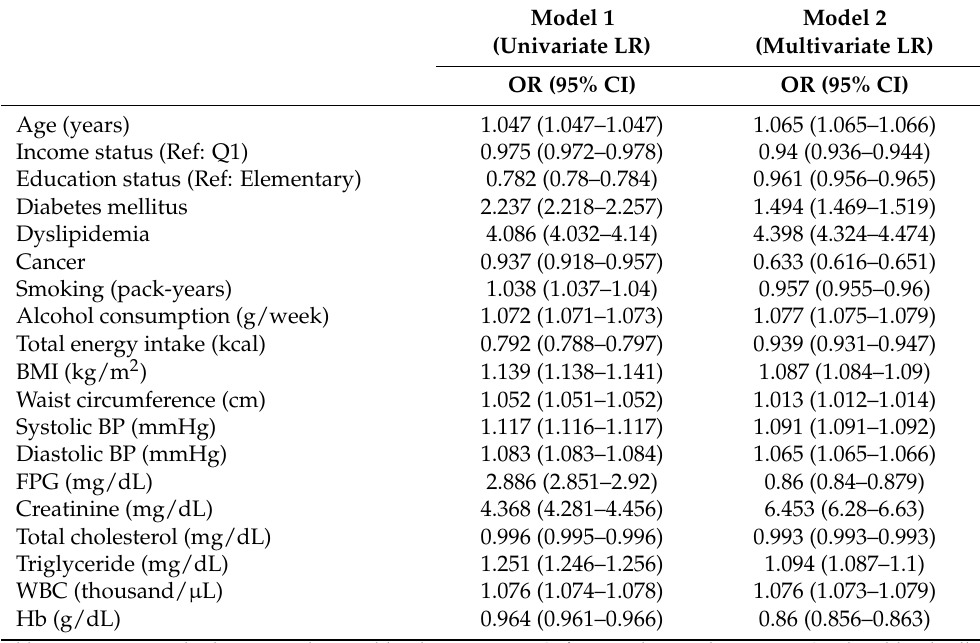
Table 2. Risk factors for hypertension selected by backward-stepwise logistic regression in Korean men.